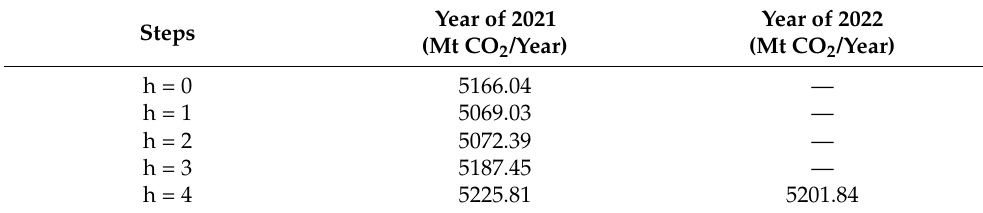
Table 6. Nowcasting and forecasting of carbon emissions of the power